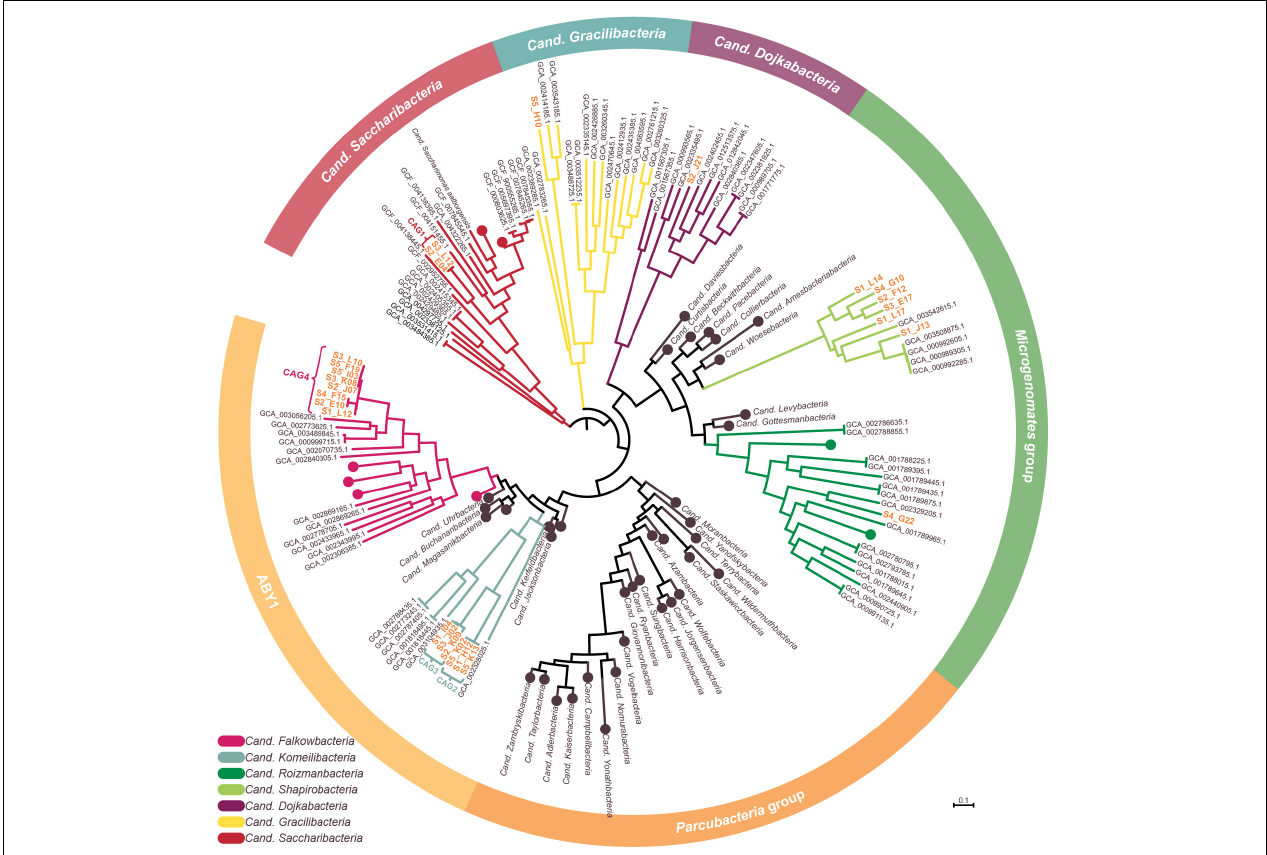
FIGURE 3 | Phylogenetic representation of SAGs and CAGs of the Patescibacteria/CPR. The tree was calculated from a marker gene-based protein alignment (Chaumeil et al., 2019) with all accessible Patescibacteria/CPR genomes from GenBank above a quality threshold of scaffold N 50 > 35 kb, completeness > 70% and paralog-corrected contamination < 5%. In total, the tree contains 975 Patescibacteria/CPR genomes and 71 genomes of the not shown Chloroflexi serving as outgroup. Clades with five or less branches were deleted from the tree for better readability and larger clades were collapsed and/or labeled based on the genomes assigned NCBI taxonomy. Two SAGs are not shown in the tree as they were too incomplete for GTDB classification. SAGs from this study are given in orange.